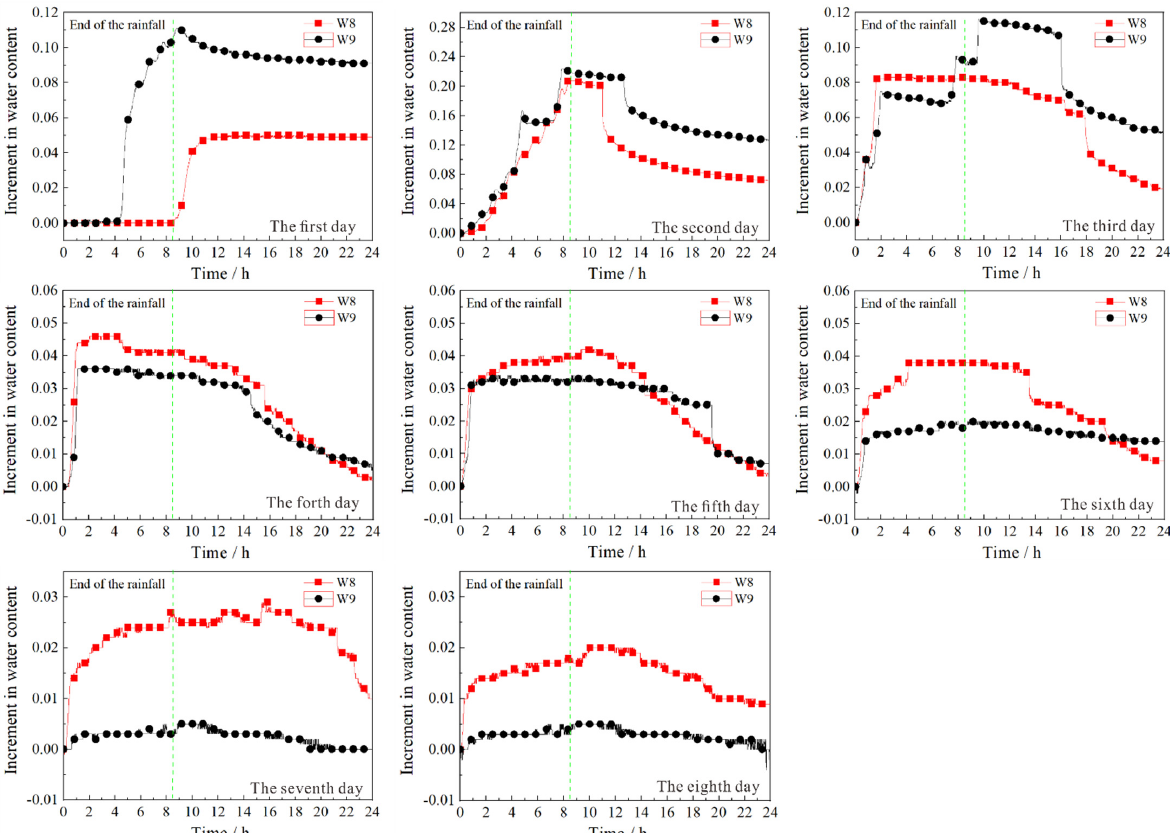
Figure 6. Variation of water content in the following days, from the first to the eighth (H3 = 0.4 m). According to the analysis of the above test results, the essence of the “interface effect” of the loess fill slope is that the interface is a rainfall dominant seepage channel, and there is a lag phenomenon of rainfall infiltration along the interface (Figures 4–6), that is, after along LFSI.